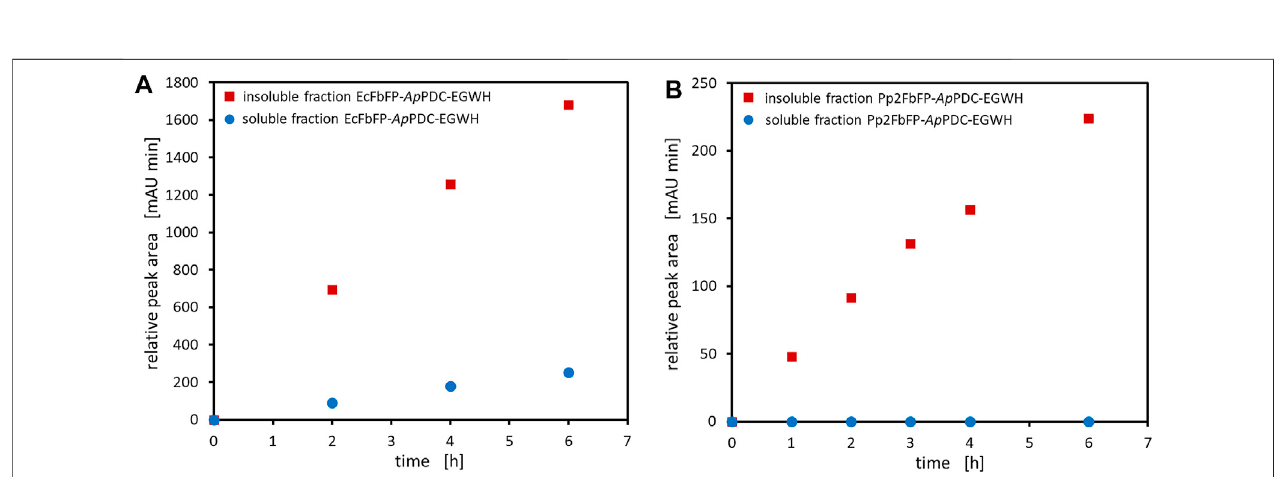
FIGURE5 | Activity test ofthe soluble and insoluble protein fraction after cell disruption of samples taken during the production ofEcFbFP- Ap PDC-EGWH (A) and Pp2FbFP- Ap PDC-EGWH (B) .Generalreactionconditions:Incubationon1 mlscaleat22 ° Cand850 rpmfor6 hinathermoshakerusing50 mMHEPESbuffer(pH7.5), 2.5 mM MgSO 4 , 0.1 mM ThDP and 200 mM pyruvate (sodium salt) with (A) 35 mM benzaldehyde and (B) 40 mM 3-hydroxybenzaldehyde. The amount of lyophilized soluble and insoluble protein was equivalent to 500 mg wet cell